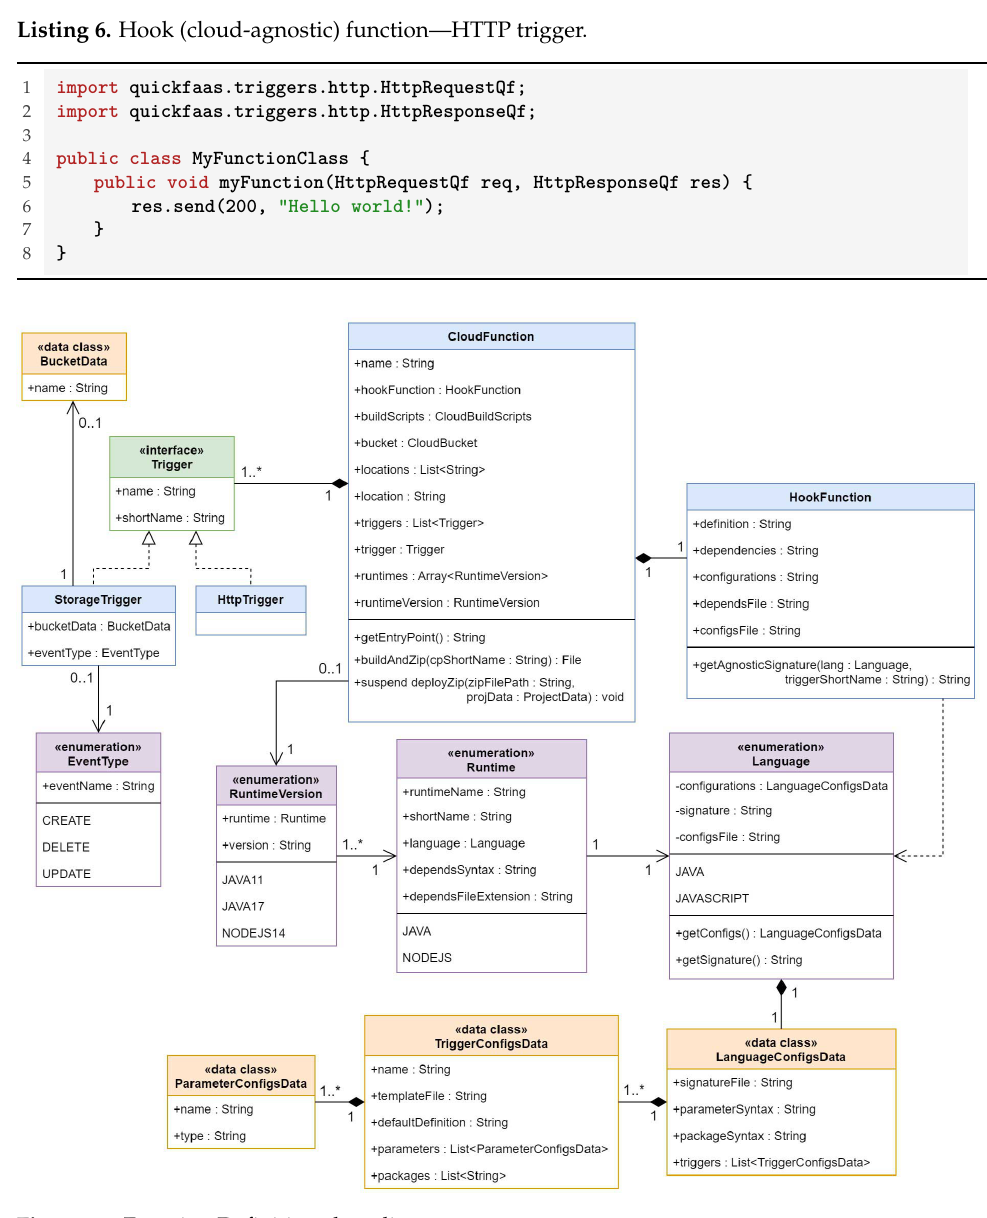
Figure 10. Function Definition class